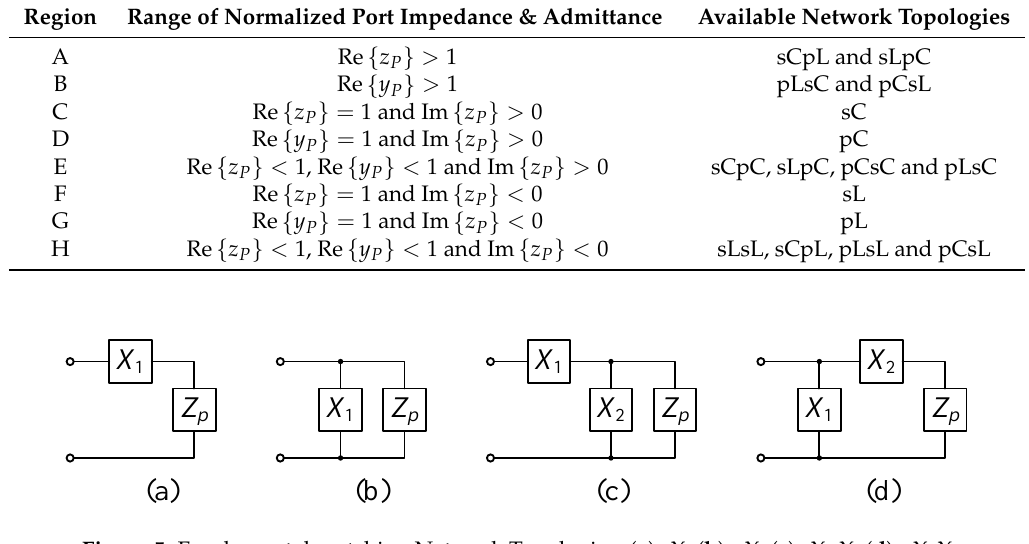
Figure 5. Fundamental matching Network Topologies: ( a ) sX; ( b ) pX; ( c ) sXpX; ( d )